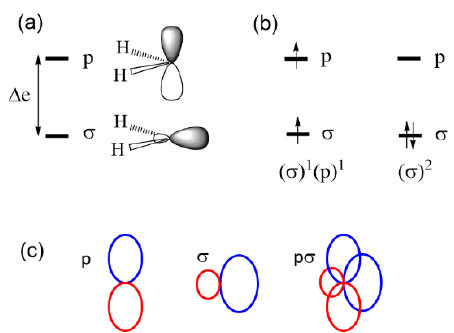
Figure 4. ( a ) Two MOs of carbine CH 2 determining the triplet and singlet states. ( b ) The triplet and singlet electron configurations of CH 2 . ( c ) The overlap density, p σ , resulting from the σ and p orbitals of CH 2 . The positive and negative lobes of the p and σ orbitals are represented by ellipses of different colors.